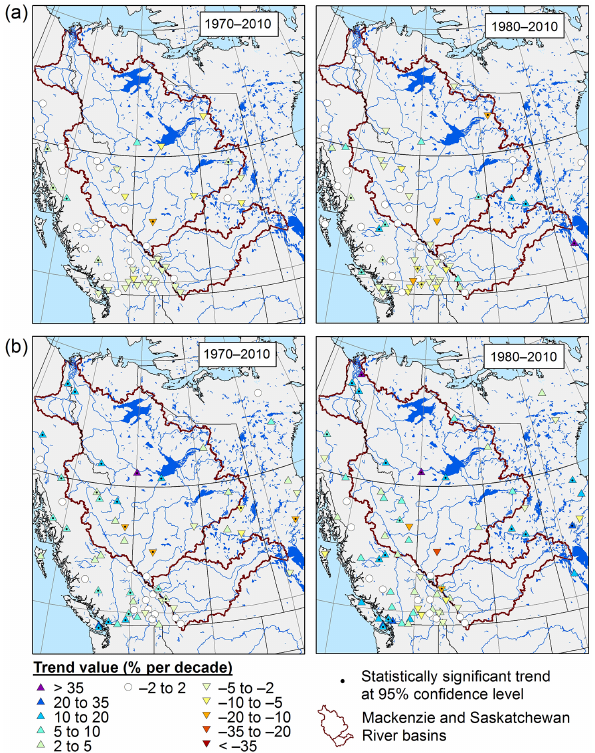
Figure 10. Spatial patterns of trends in (a) annual discharge and (b) January discharge from RHBN stations over western Canada for the periods 1970–2010 and 1980–2010. Rejected stations are